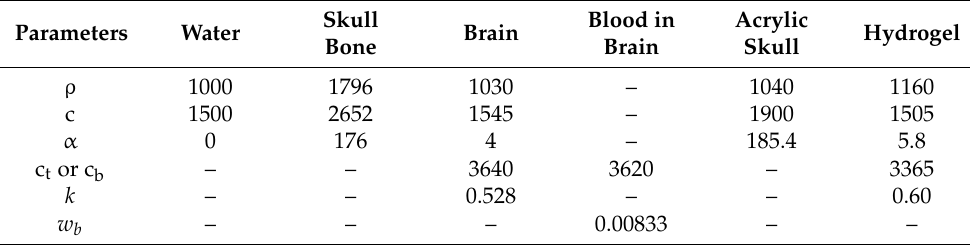
Table 1. Parameters used in numerical simulations [47,48]. Parameters Water